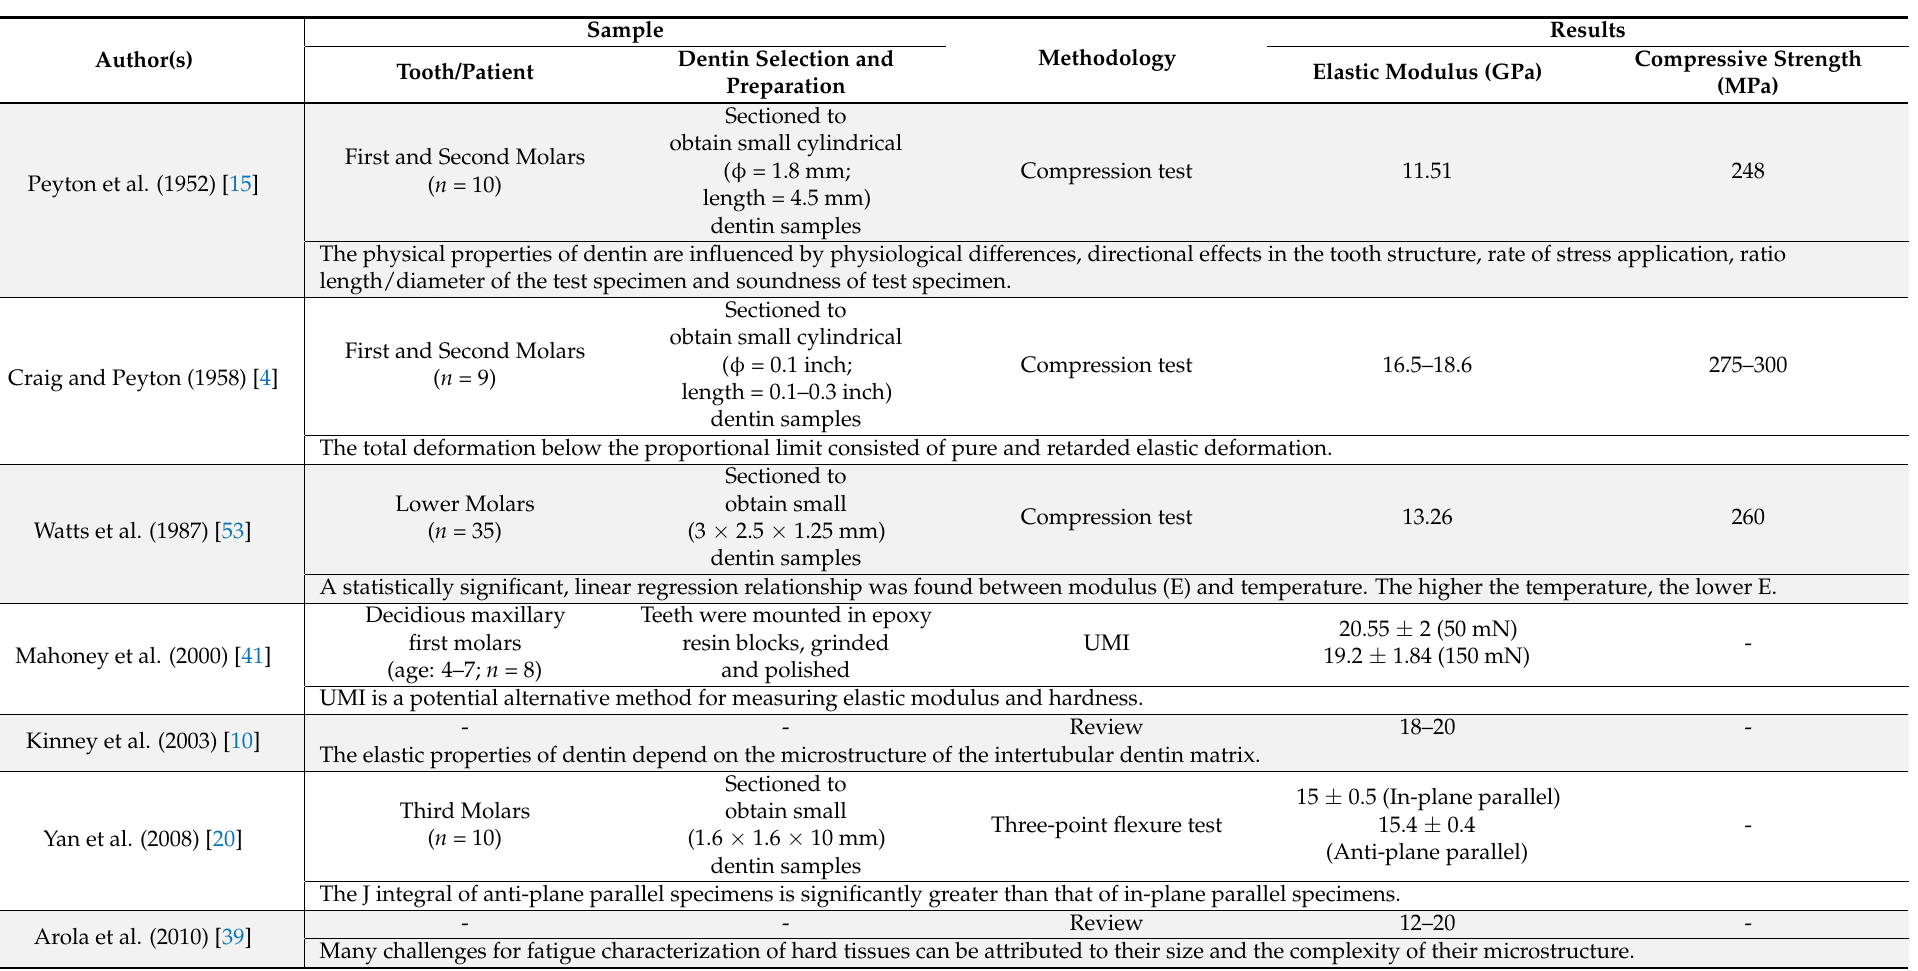
Table 2. Dentin Mechanical Properties: sample characterization, methodology used and results obtained from the different